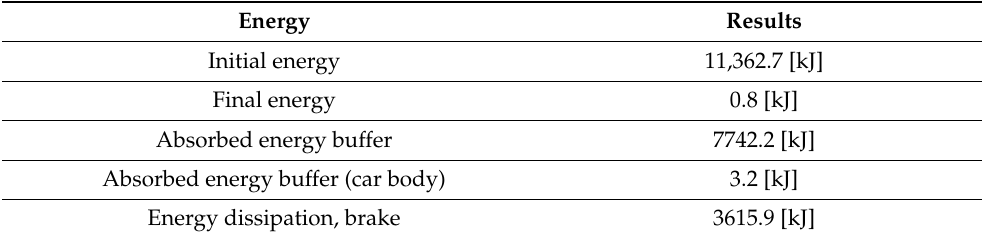
Table 3. Result of energy